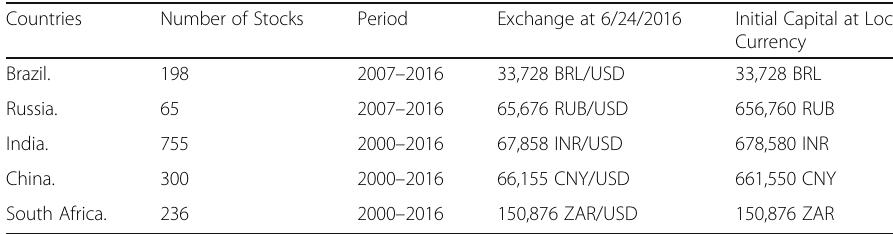
Table 2 Information of countries Countries Number of Stocks Period Exchange at